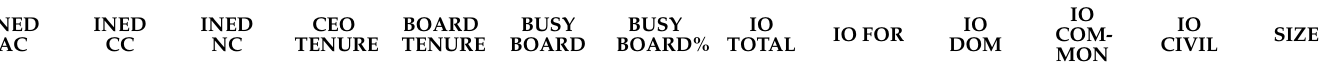
Table 1. Descriptive statistics and correlation